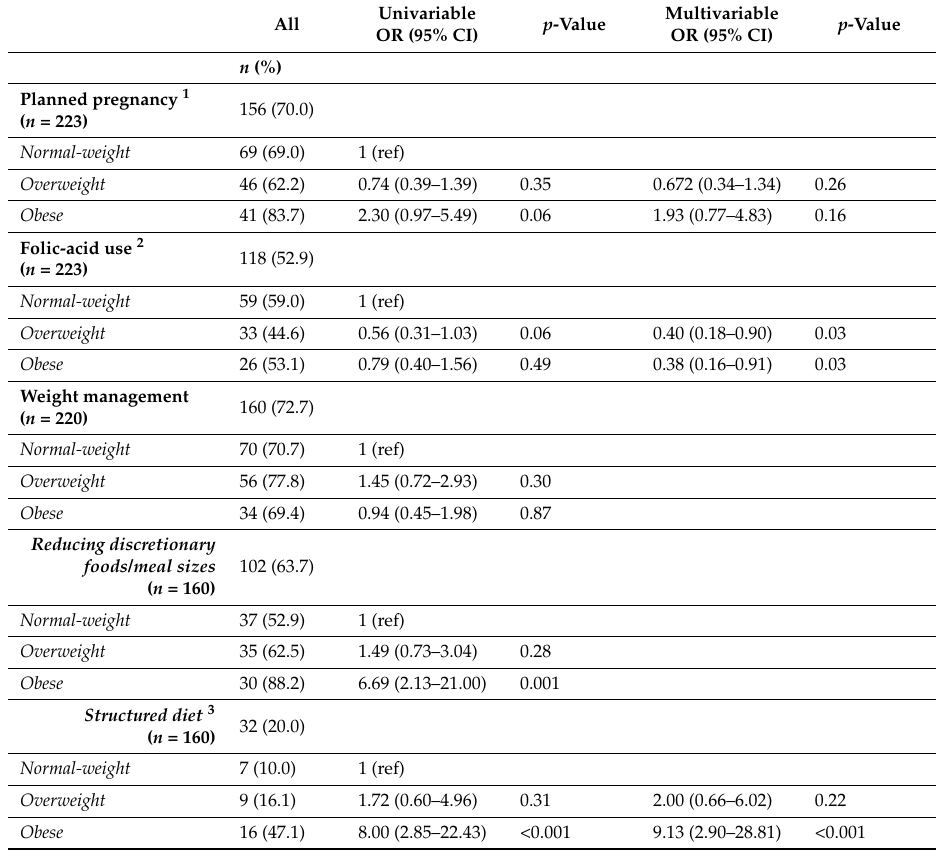
Table 2. Preconception health behaviors and